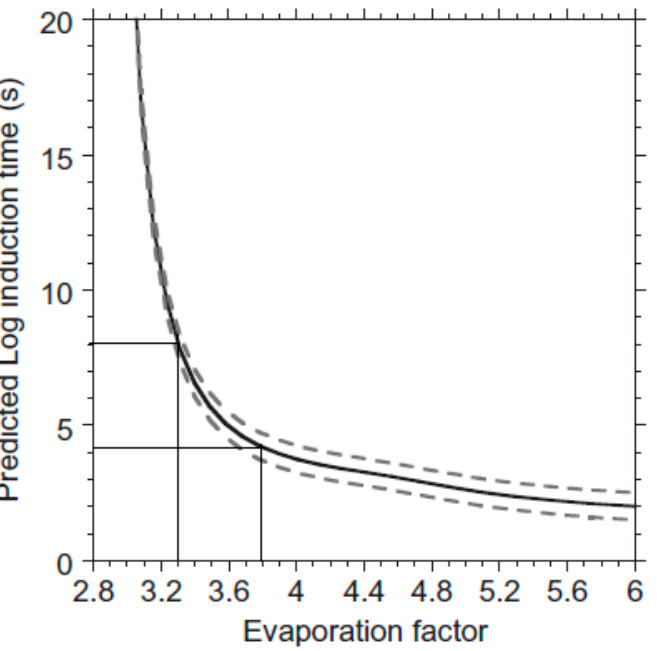
Figure 6. Calculated log( T ind ) for gypsum from seawater undergoing evaporation as a function of the evaporation factor, as calculated from Equation (7). The vertical and horizontal black lines are calculated log( T ind ) at evaporation factors of 3.3 and 3.8 at which reportedly gypsum precipitates from seawater. Reprinted from Reznik et al. [79] with permission from Elsevier.